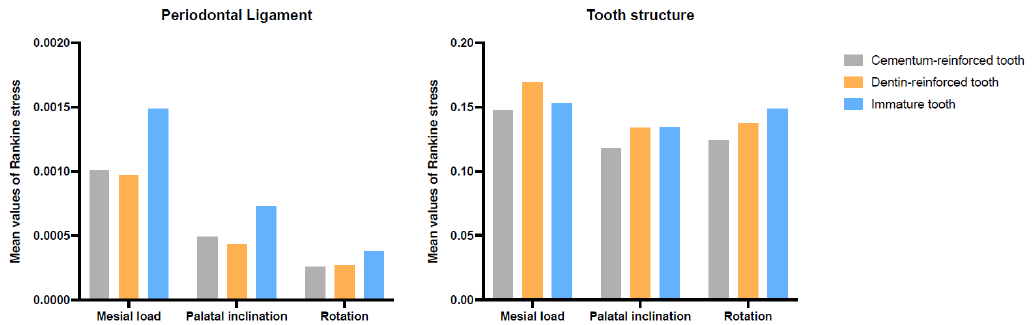
Figure 2. Mean Rankine stress of the teeth and periodontal ligament of Models 1, 2 and 3 for mesial load, palatal inclination and rotation scenarios.